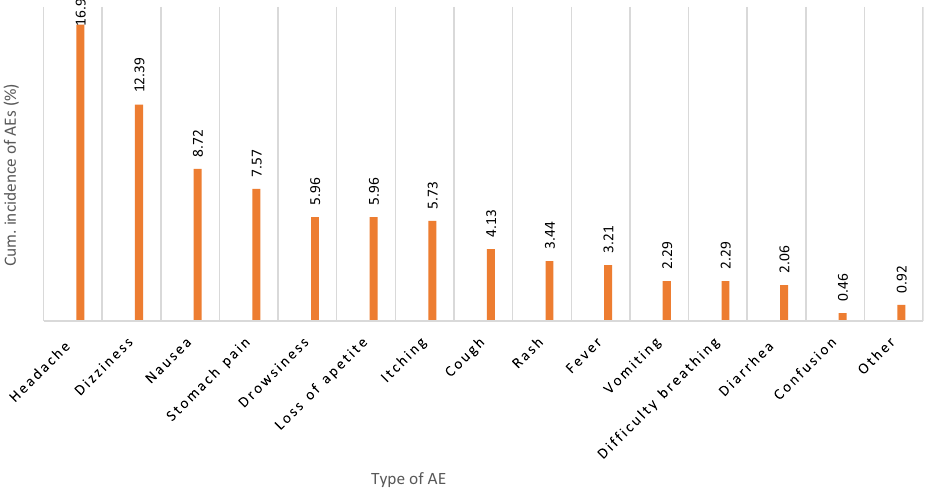
Table 5. The geometric mean cis -4-OH-PZQ/PZQ MR was significantly lower among those who experienced adverse events compared to those who did not (p < 0.0001). There was also difference in crude and adjusted mean cis metabolic ratios among those children who experience adverse events compared to those who did not. After adjusting for age, weight and height, children who experienced adverse events had a mean decrease cis -4-OH-PZQ/PZQ concentration of 0.131 (p < 0.01; 95% CI − 0.223 to − 0.039) compared to children who did not experience adverse events. There was no statistically significant difference in trans -4-OH-PZQ/PZQ MR concentration between children who experienced adverse events compared to those who did not. Univariate fol- lowed by multivariate logistic regression analysis indicated no association between CYP3A4 , CYP3A5 , CYP2C9 ,